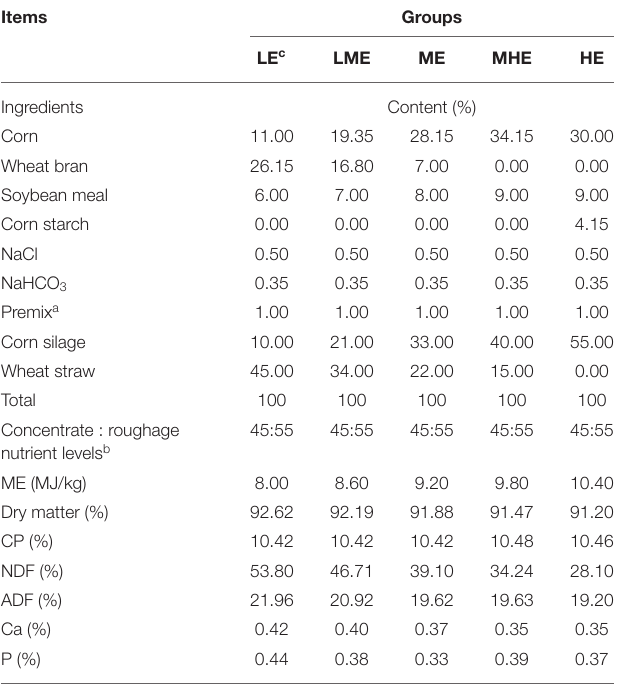
TABLE 1 | Composition and nutrient levels of experimental diets. Items